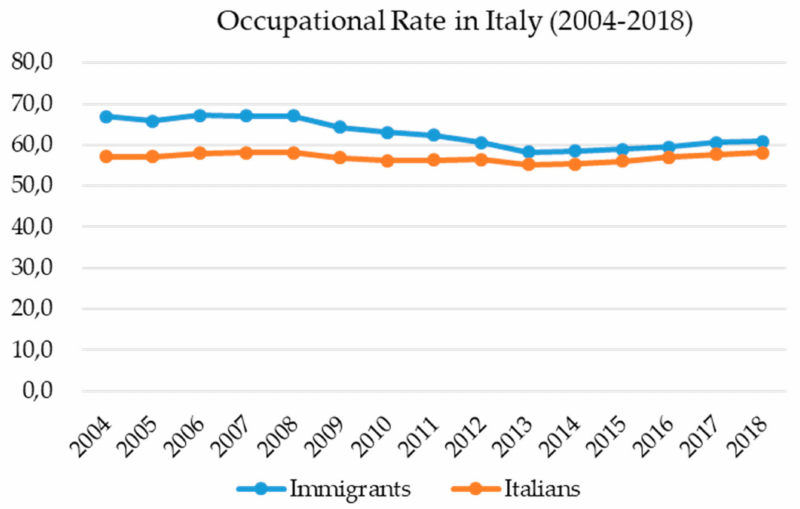
Figure 1. This graph shows the occupational rate in the years 2004–2018 of immigrant and Italian workers with resident